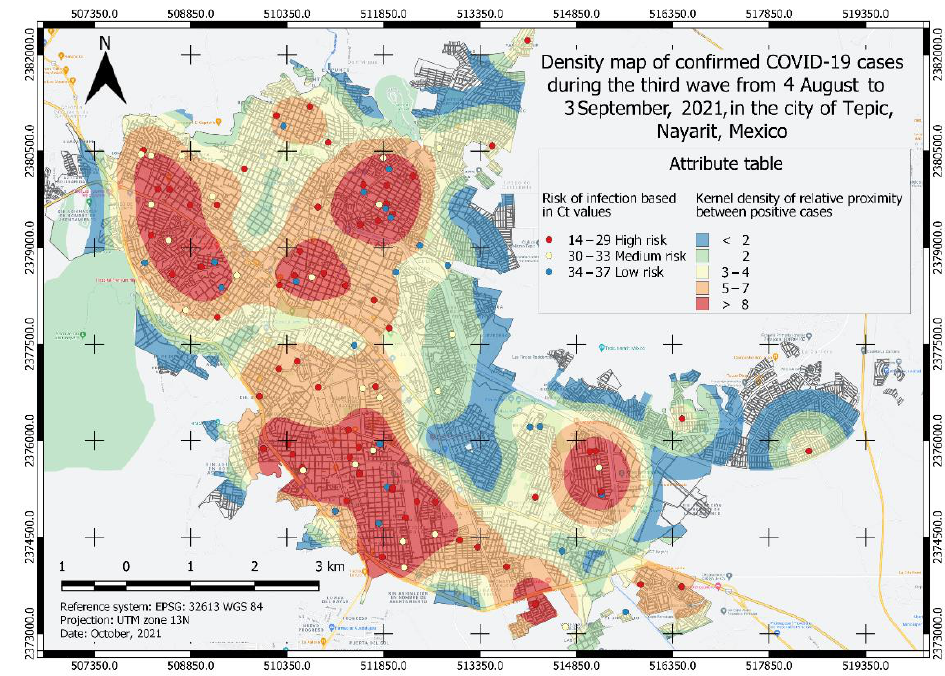
Figure 4. Density map of confirmed COVID-19 cases in the third wave from 4 August to 3 September 2021, in the city of Tepic, Nayarit, Mexico. The different areas classified by color indicate the level of risk of probability of contagion of the COVID-19 disease and each point corresponds to a confirmed case categorized by its Ct value.